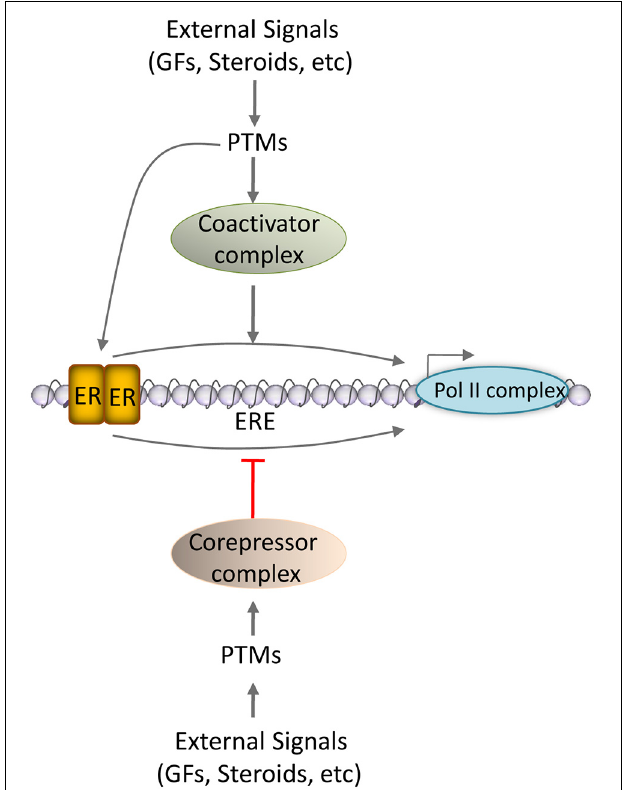
FIGURE 1 | Coregulator action on ER signaling. Schematic representation of the action of coregulators on ER activity is comprised of three tiers. In the tier 1, coactivators facilitate ER interaction with RNA Polymerase II complex to enhance the target gene transcription. On the other hand, the corepressors affect ER interaction with RNA Polymerase II complex to suppress the target gene transcription. In tier 2, various post-transcriptional modifications (PTMs) that include phosphorylation, methylation, acetylation, sumoylation, etc., of coregulators further impact on their ability to modulate ER functionality. In tier 3, external signals like growth factors and steroid hormones may influence the post-translational modifications of coregulators. ERE, estrogen response